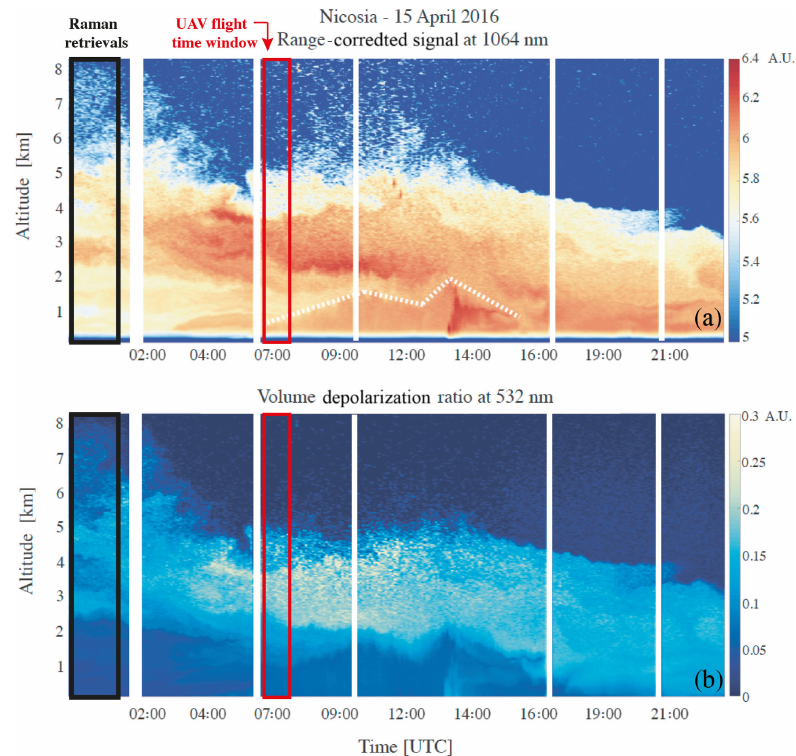
Figure 5. Range-corrected lidar signal at 1064nm (a) and volume linear depolarization ratio (b) reflecting the atmospheric conditions over Nicosia on 15 April 2016. Blue colour indicates weak backscattering, yellow–red colours in the range-corrected lidar signal indicate backscattering mainly from fine aerosols and dust, whereas the dotted line shows the PBL top. The lidar observations used for the comparison with the UAV measurements were those recorded between 07:00 and